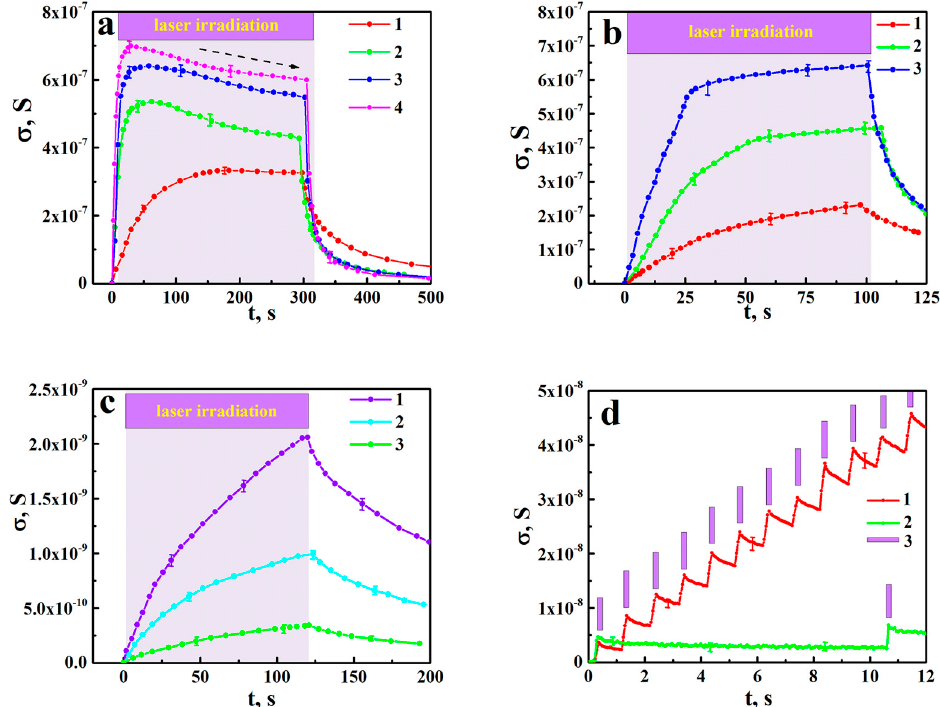
Figure 3. The experimental data on the temporal evolution of the dc conductance of aTNTA under laser irradiation: ( a – c ) long-term behavior of conductance under the action of pulse sequences, ( a ) the fixed repetition rate (10 Hz) and wavelength (355 nm) with varied irradiation fluence (1—0.1 mJ/cm 2 , 2—1.0 mJ/cm 2 , 3—2.2 mJ/cm 2 , 4—4.0 mJ/cm 2 ); ( b ) the fixed irradiation fluence (3.5 mJ/cm 2 ) and wavelength (355 nm) with the varied repetition rate (1—2 Hz, 2—6 Hz, 3—10 Hz); ( c ) the fixed irradiation fluence (3.5 mJ/cm 2 ) and repetition rate (10 Hz) with the varied wavelength (1—425 nm, 2—475 nm, 3—525 nm); selectively shown error bars correspond to the significance level of 0.9; ( d ) short-term behavior under irradiation at low repetition rates (1—1 Hz; 2—0.1 Hz; 3—the moments of pulse laser irradiation On); irradiation fluence is 3.5 mJ/cm 2 and the wavelength is 355 nm.